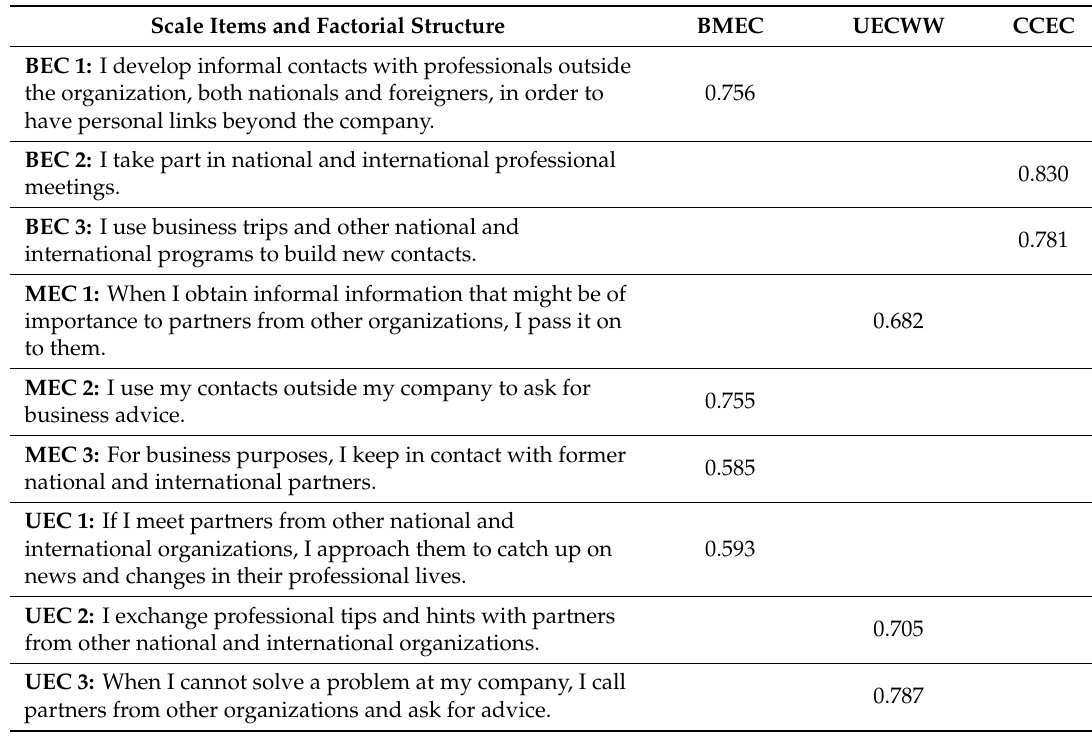
Table 2. Exploratory factor analysis matrix for external networking behavior